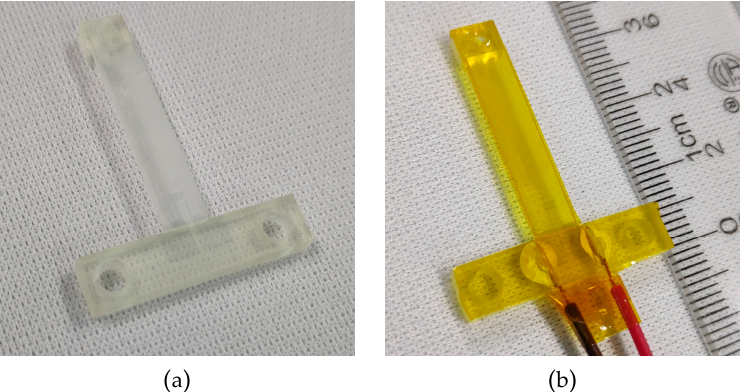
Figure 12. Pictures of the force sensor: ( a ) After inkjet printing; ( b ) after bonding wires and sealing.